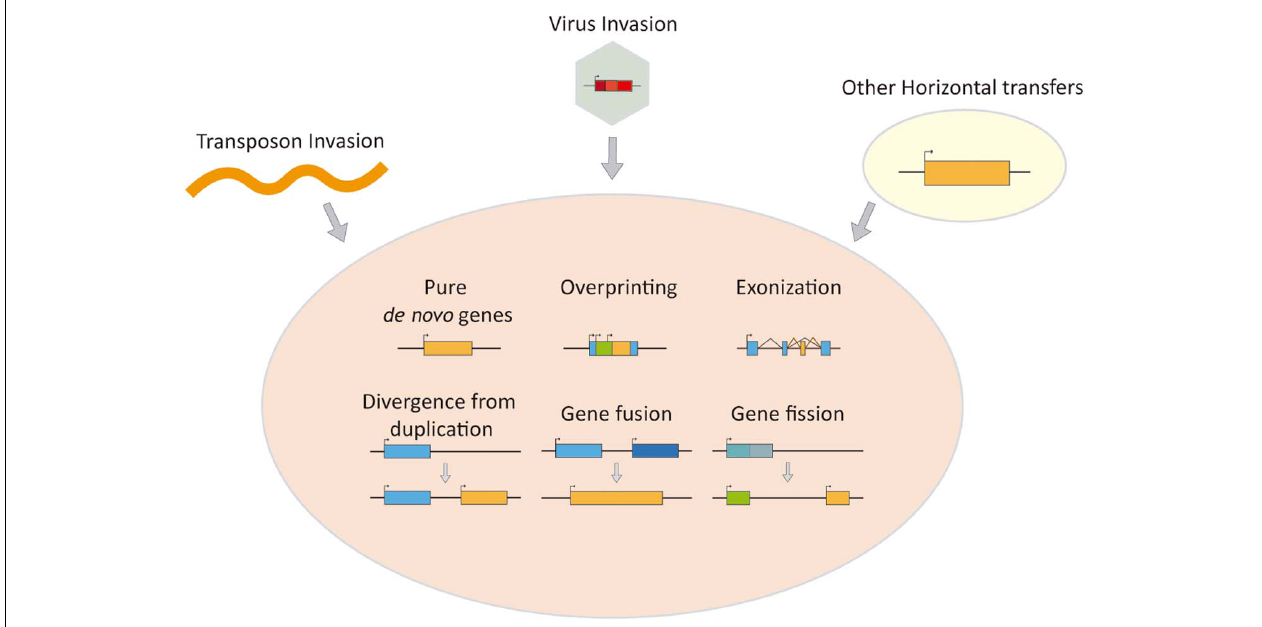
FIGURE 1 | Schematics of mechanisms for generating de novo